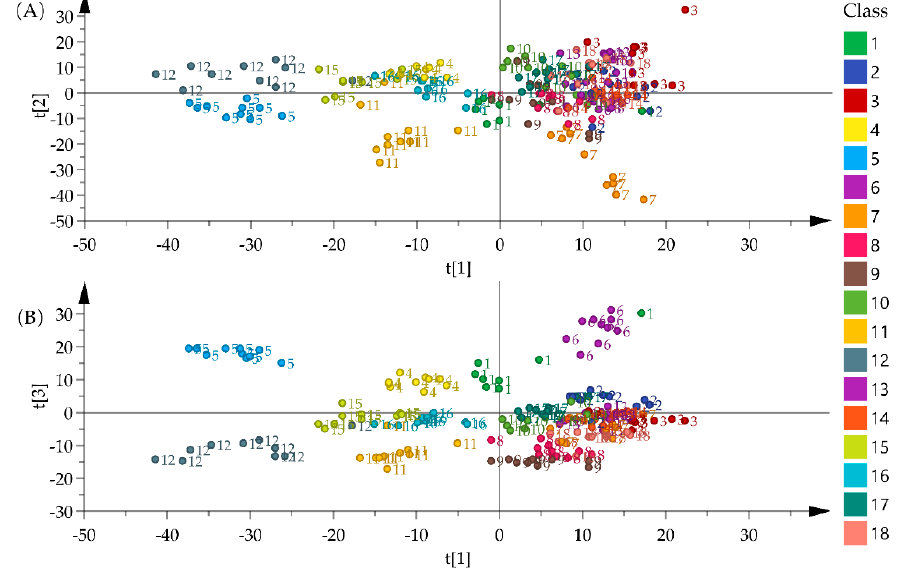
Figure 5. Score plots of PCA for 180 samples using FT-MIR spectra after pretreatment ( A ) score plot of PC1 vs. PC2, ( B ) score plot of PC1 vs. PC3. The meaning of the codes (1–18) could be found in the sample